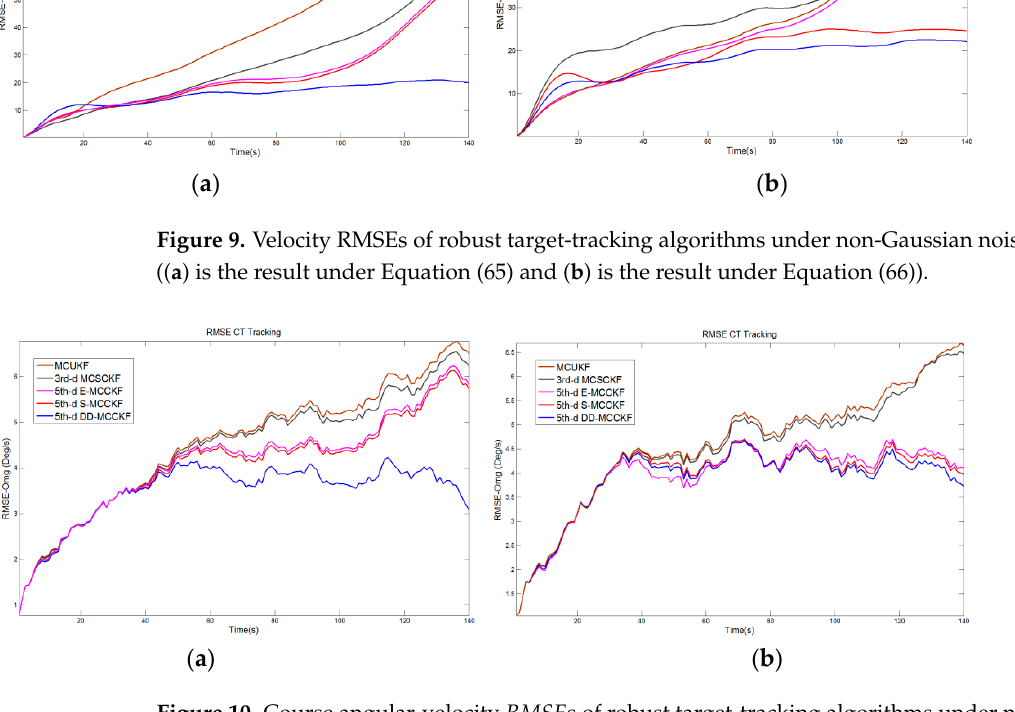
Figure 10. Course angular-velocity RMSE s of robust target-tracking algorithms under non-Gaussian noise conditions (( a ) is the result under Equation (65) and ( b ) is the result under Equation (66)). The running time of the algorithm was 140 s. Among the position errors of the simulation results, the accuracy of the MCUKF was the worst owing to the numerical instability and inaccurate UT. Because of the high system dimensions, the approximation process of the ECKF was unstable, and its filtering performance was worse than that of the S-MCCKF. Especially in the position RMSE index, the ECKF was particularly affected by the instability of its formula value, and its filtering accuracy is even lower than that of the 3rd-degree